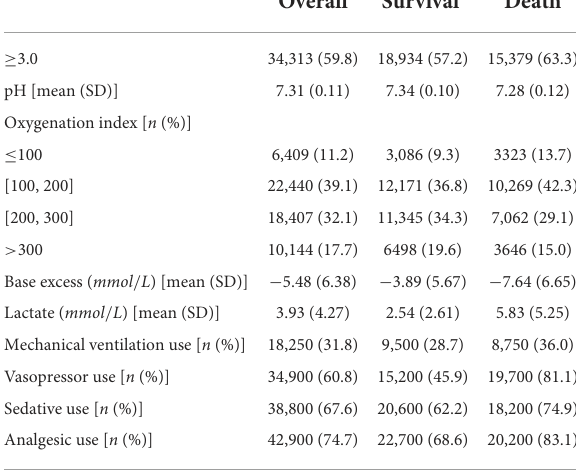
TABLE 1 Clinical characteristics of the development